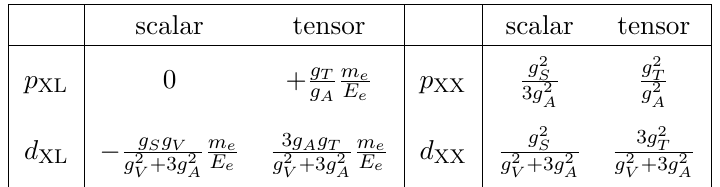
Table 2 . The same as table 1 but now for production and detection factors for solar neutrinos .